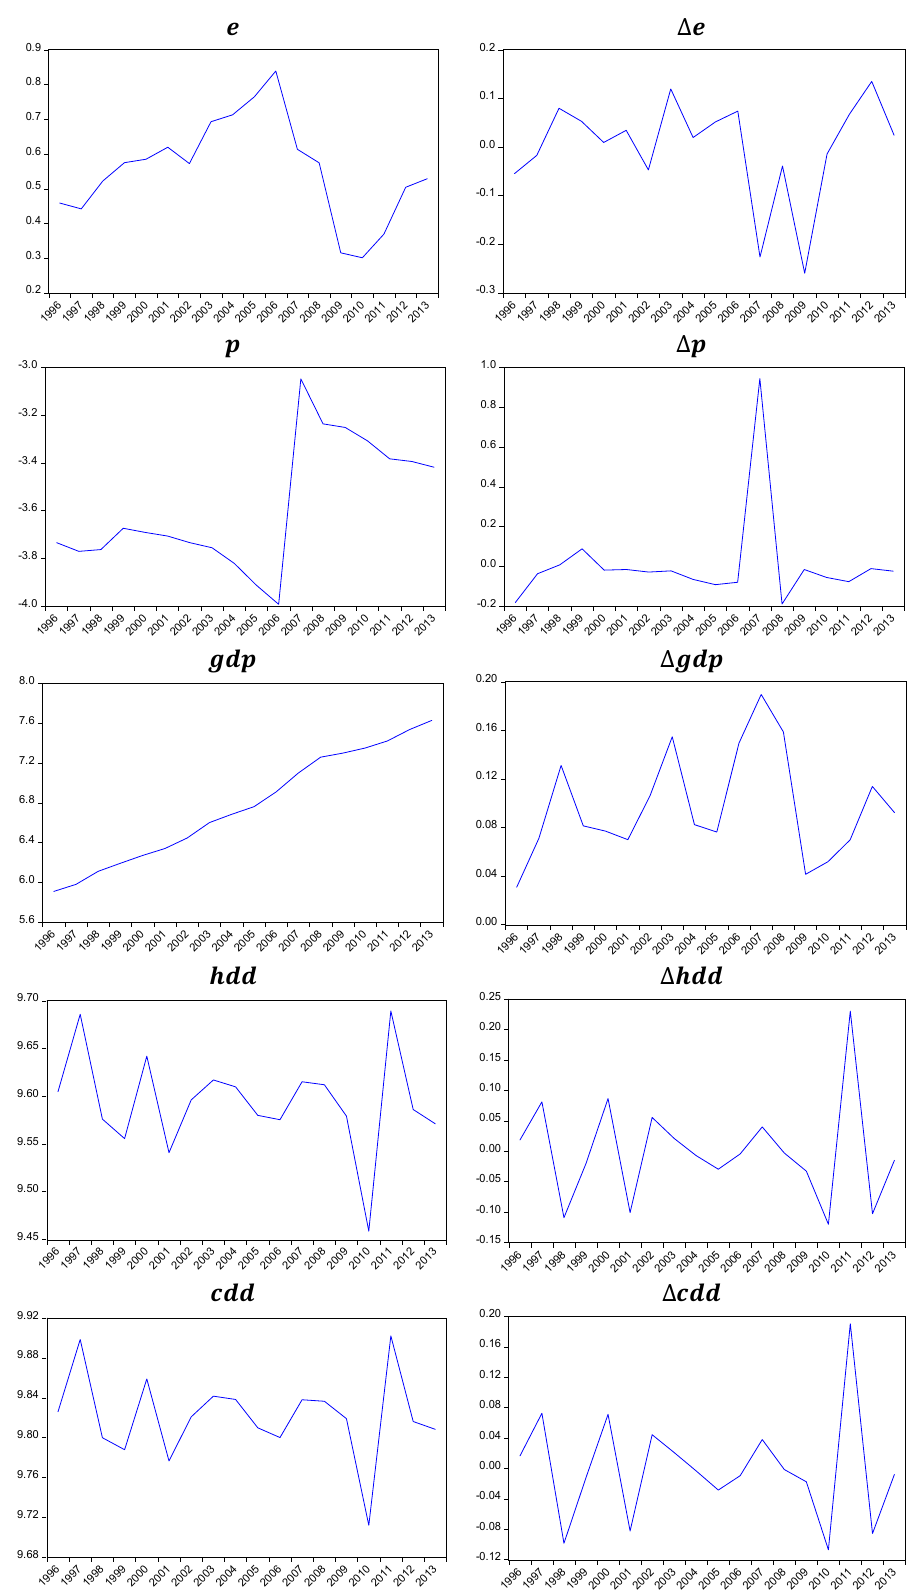
Figure 2. Level of Natural Logarithm and Growth Rates of Variables.